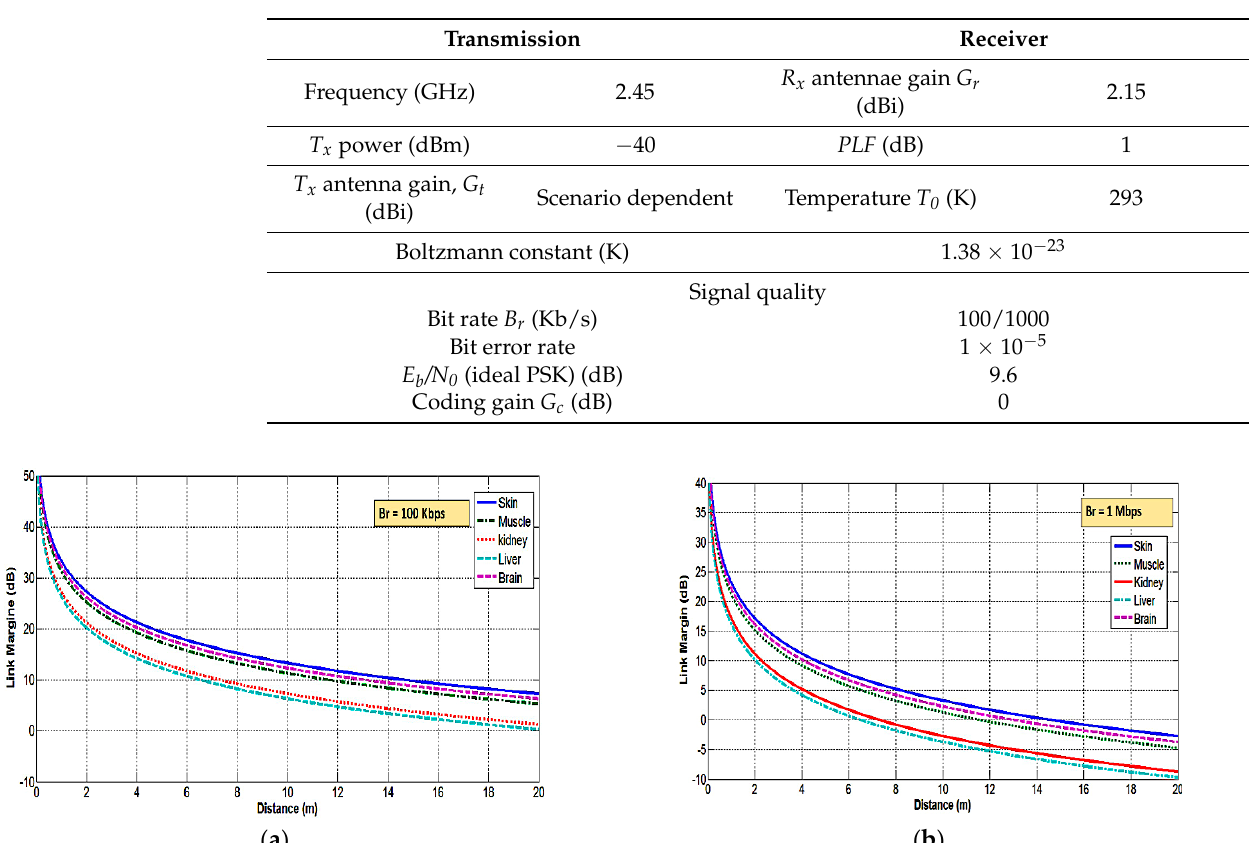
Table 4. Absorption rate calculation parameters.